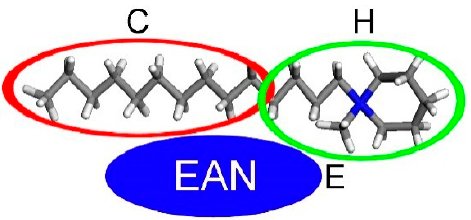
Figure 7. Simulation model of C n PDB in EAN. The C n PDB molecule is divided into two parts, alkyl-chain ( C ) and headgroup ( H ). Water is represented by ( E